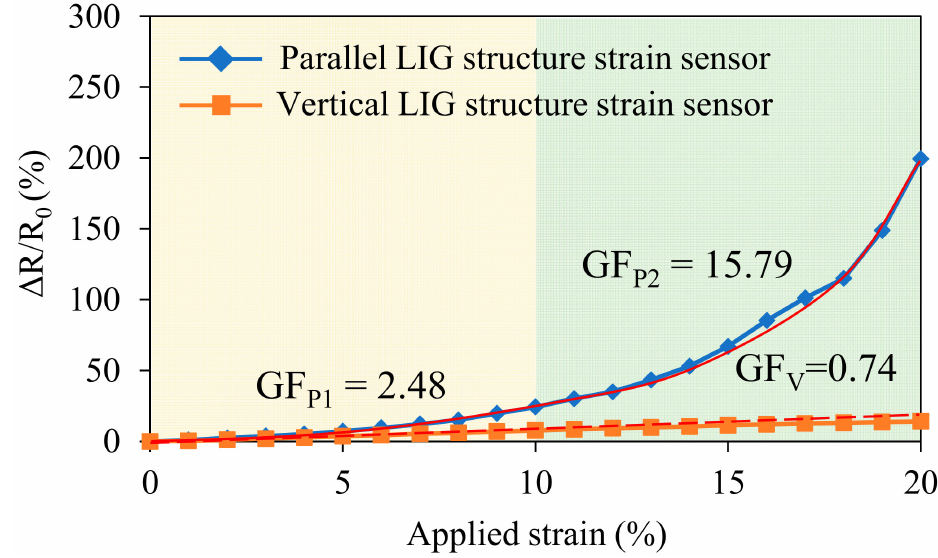
Figure 10. Relative resistance changes with different applied strain values for the parallel and vertical LIG strain sensors.